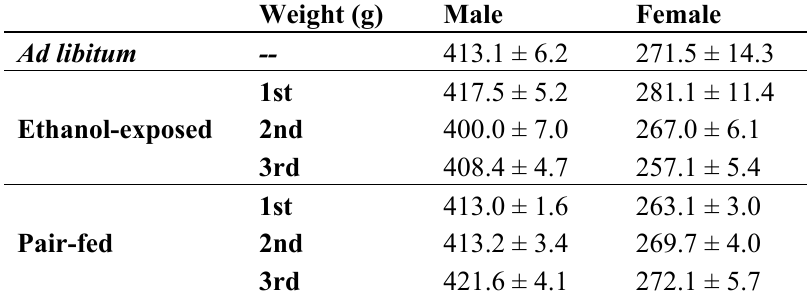
Table 3. Effect of perinatal ethanol exposure on offspring body weight at experimental age. When reaching early adulthood, males weighed significantly more than females and therefore their weights were analyzed separately. There were no significant effects of perinatal condition on body weight in either males or females (see text for statistical details). Results are expressed as means ± SEM. Results are considered statistically significant if p <